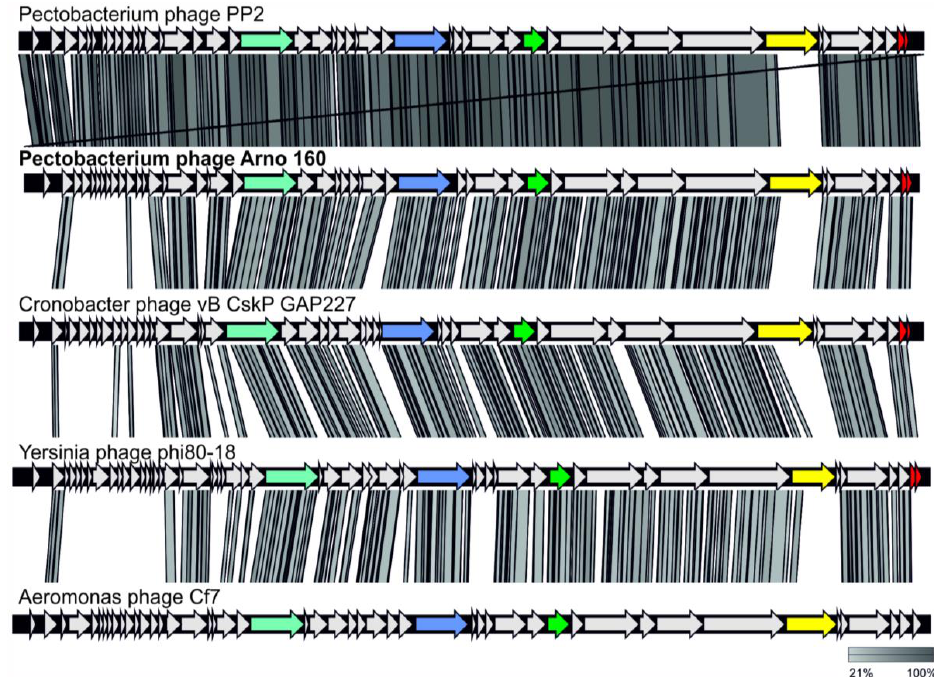
Figure 5. Pairwise comparison of the phage genomes Pectobacterium phage Arno 160, Pectobacterium phage PP2, Cronobacter phage vB_CskP_GAP227, Yersinia phage phi80–18 and Aeromonas phage